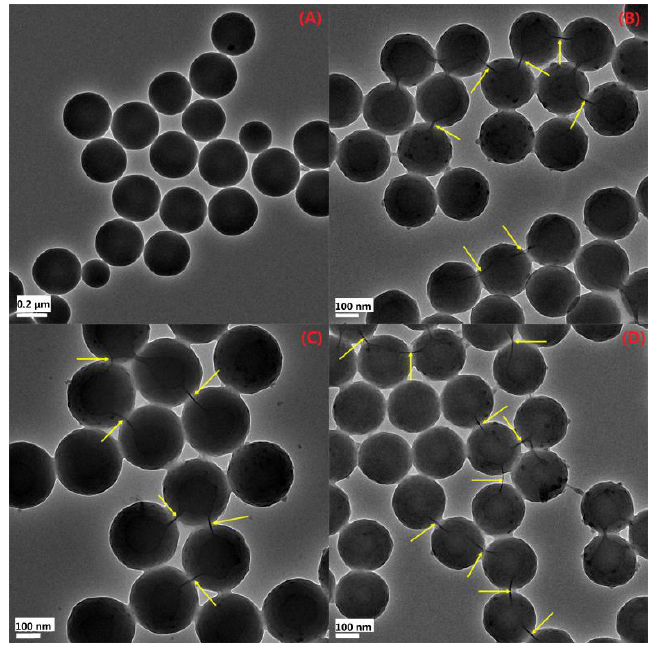
Figure 7. Transmission electron microscopy (TEM) images of ( A ) PS, ( B ) PS/P-MMT, ( C ) PS/P-SLS-MMT, and ( D ) PS/P-KH570-MMT.